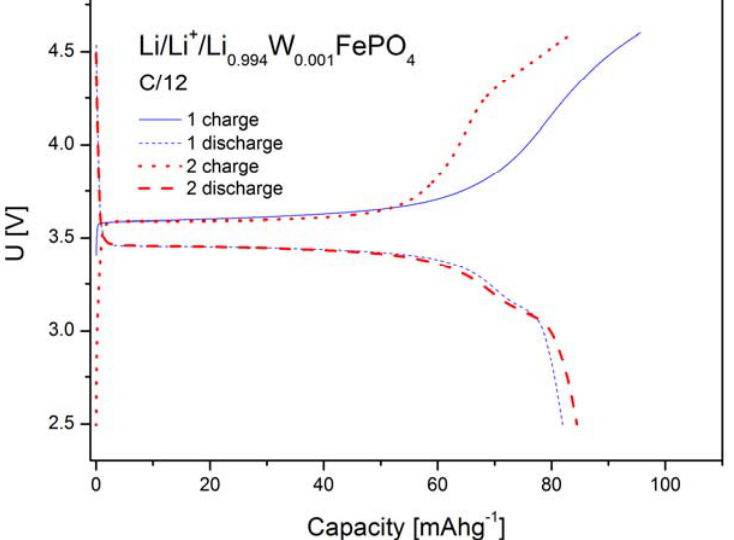
W FePO 0.994 0.001 4